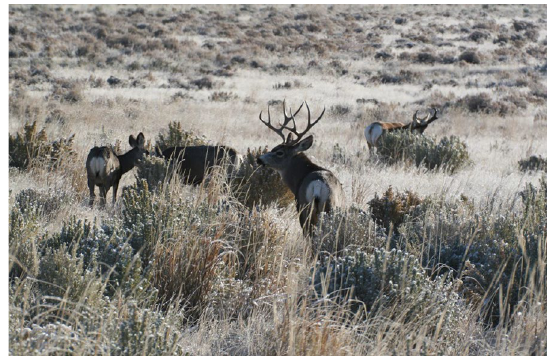
Fig. 9 Reestablished Shrubland community (2005–2007)